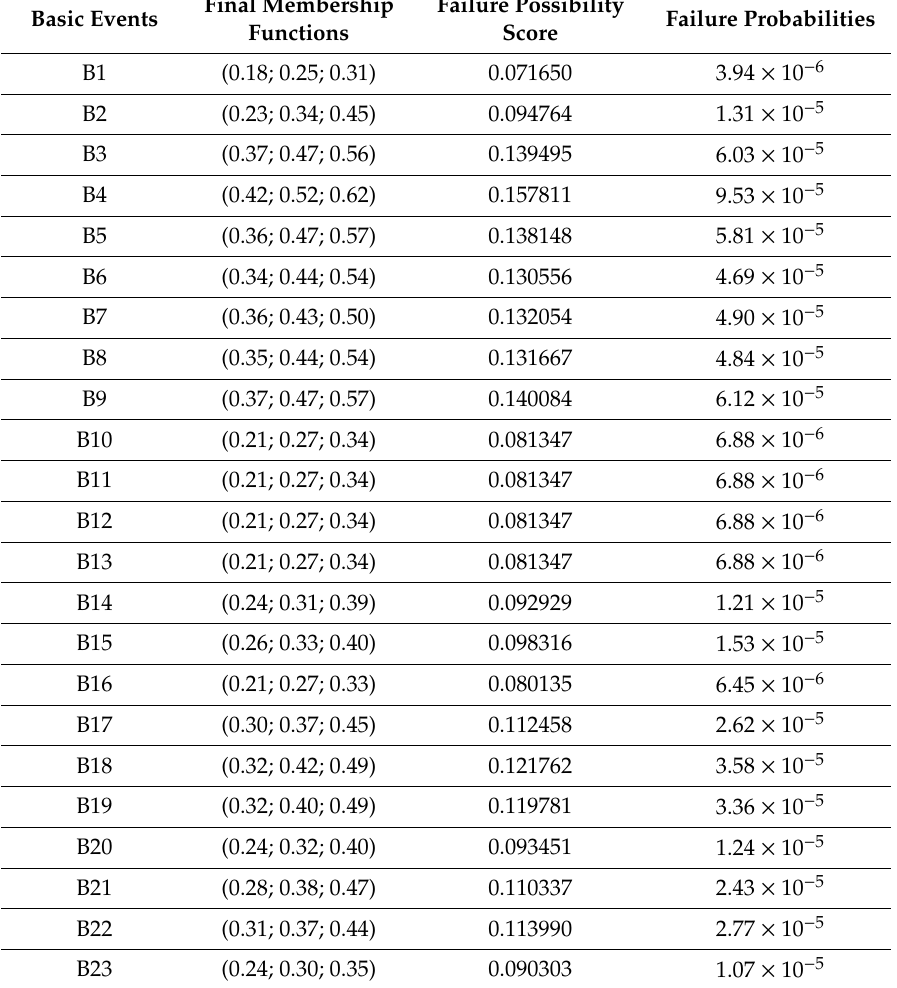
Table 5. Data generated by the fuzzy fault tree analysis (FFTA)